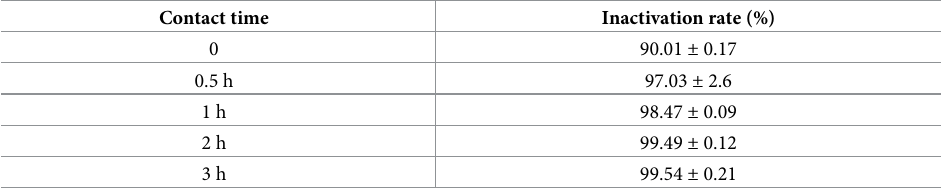
Table 2. Inactivation rate of the LEO-MWCNTs filters to E . coli cells captured on the filters with different incuba- tion time after the filtering step. Contact